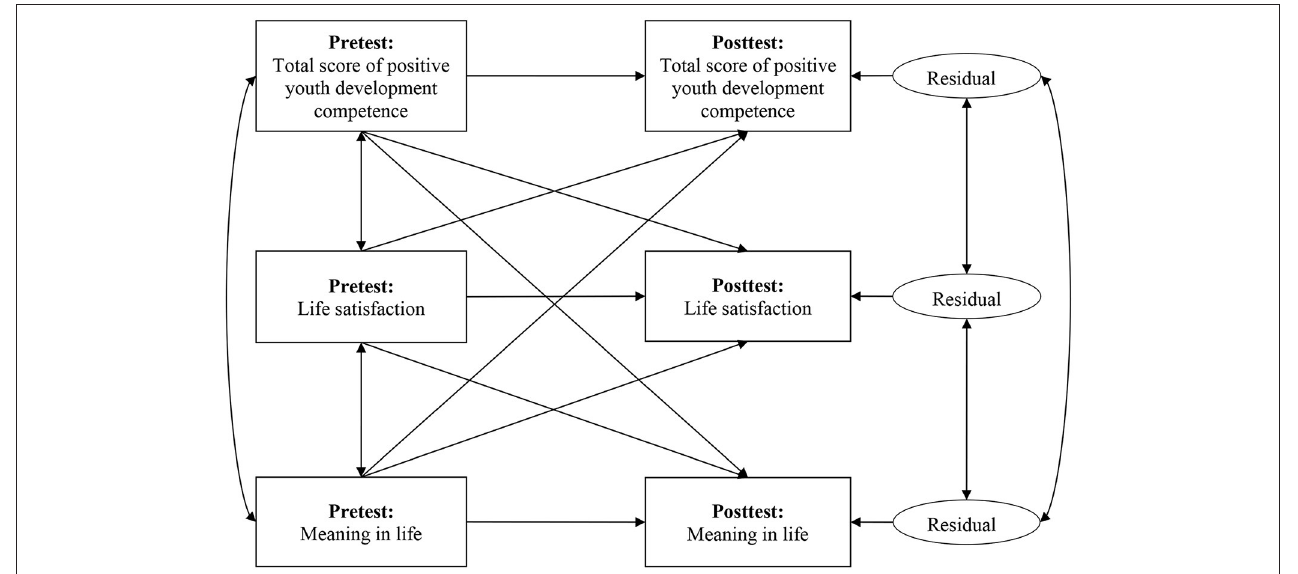
FIGURE 1 | Cross-lagged panel model among positive youth development, life satisfaction, and meaning in life in pretest and posttest.